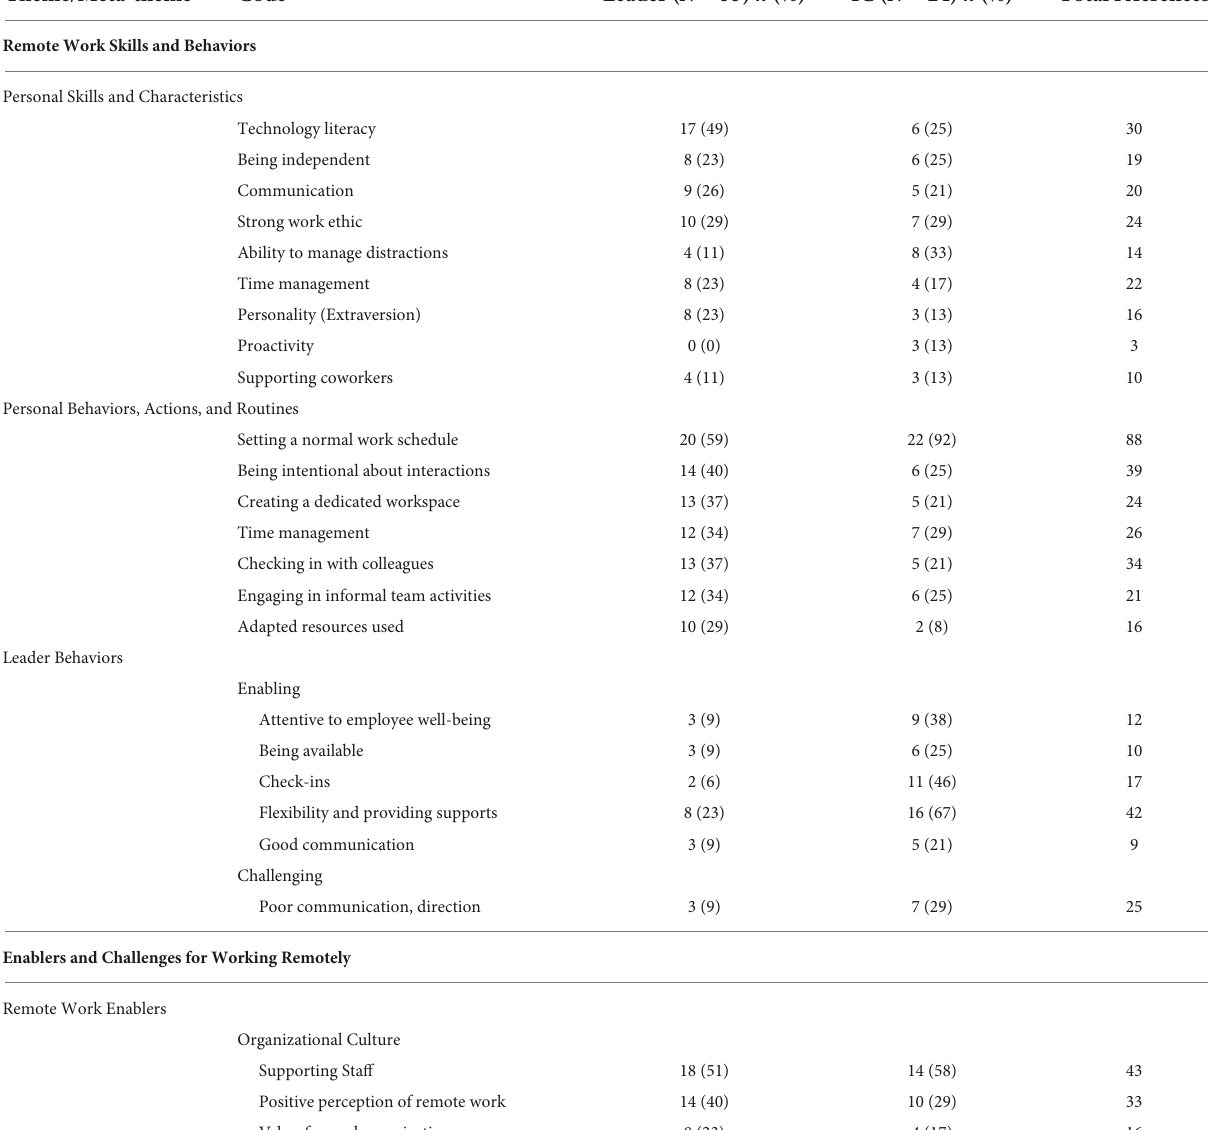
TABLE 2 Summary of interview codes and